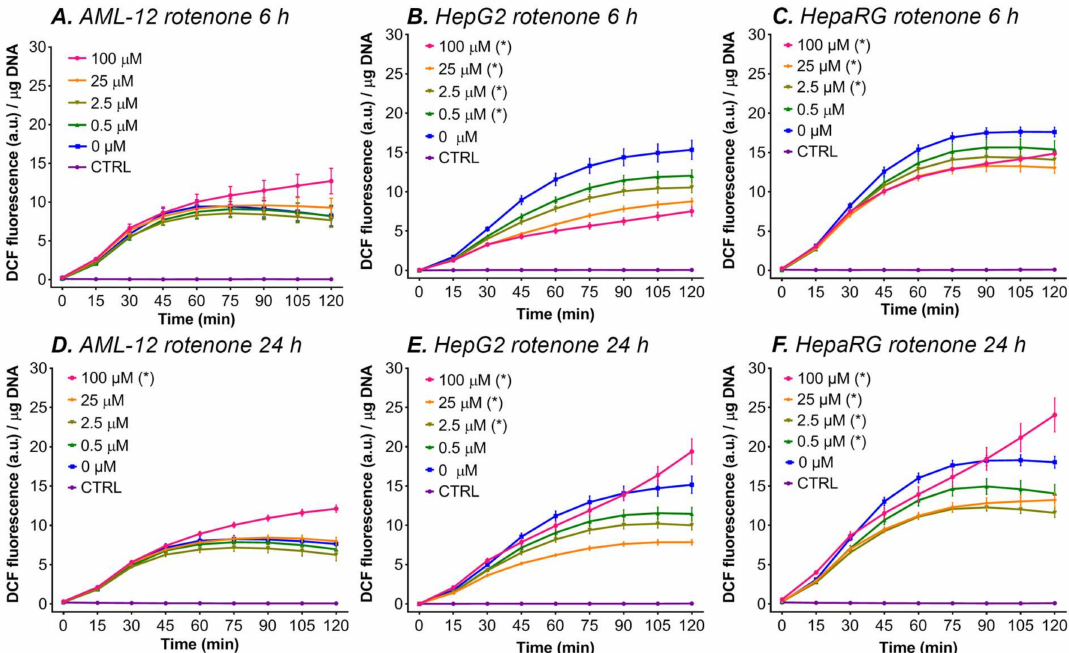
Figure 3. DCF fluorescence per µ g DNA during a 2-h kinetic read after rotenone incubation for 6 or 24 h in AML-12, HepaRG, and HepG2 cells. The data are presented as mean ± SEM (n = 8 per group) for AML-12 and HepG2 cells and as the mean ± SEM (n ≥ 3/group) to increase graph legibility for HepaRG cells. (*) = ∆ flu (fluorescence at t = 120 − t = 0) is significantly different vs. 0 µ M ( p < 0.05 one-way ANOVA, Dunnett’s post hoc test). The control (CTRL) cells were not incubated with DCFH 2 -DA. Abbreviations: DCF = 2 (cid:48) ,7 (cid:48) -dichlorofluorescein; a.u. = arbitrary